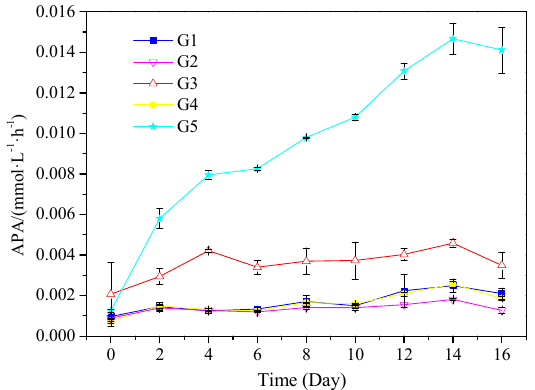
Figure 5. Growth rate of M. aeruginosa in culture systems with different P source.